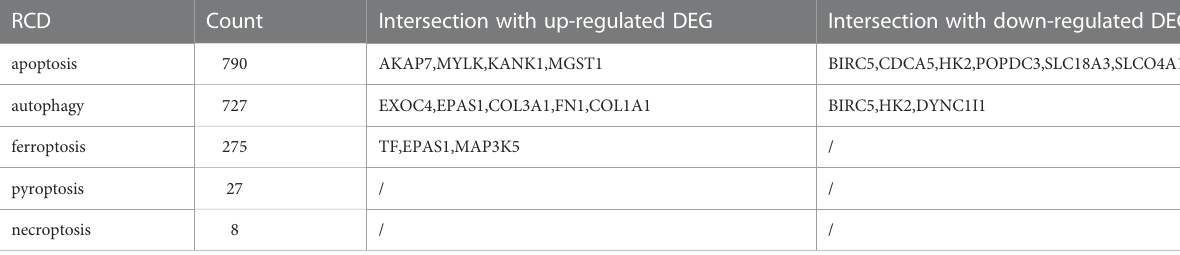
TABLE 3 Intersection genes of DEGs and RCD